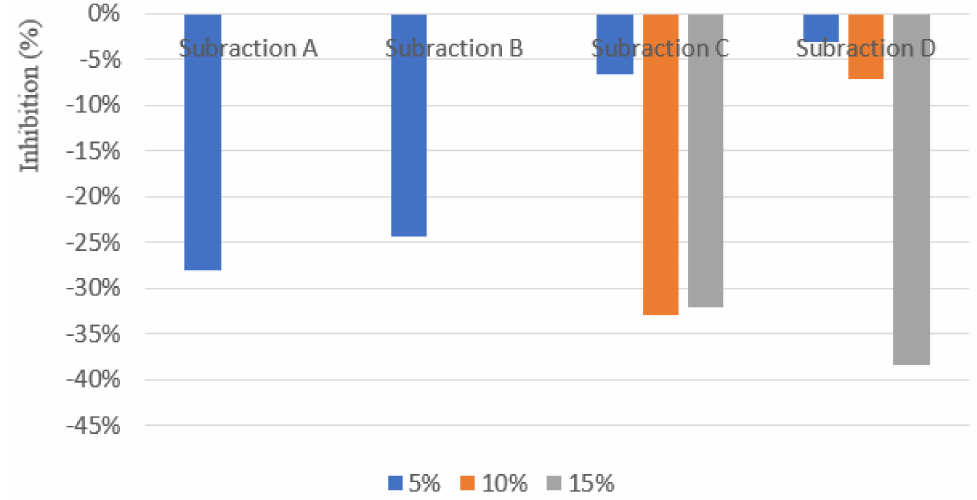
Figure 3. Effect of ethyl acetate A. conyzoides extracts at different subfractions on shoot dry weight of A. spinosus at 21